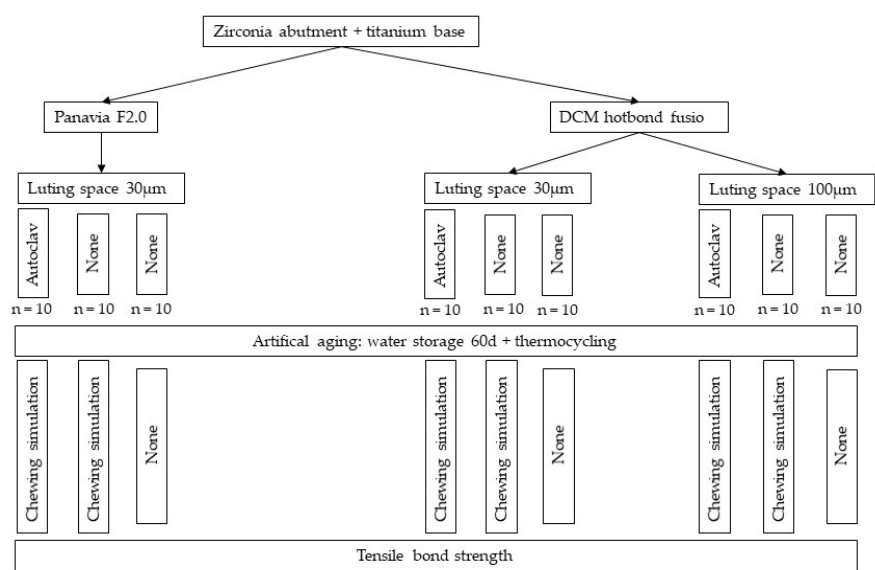
Figure 1. Study Figure 1. Study protocol.